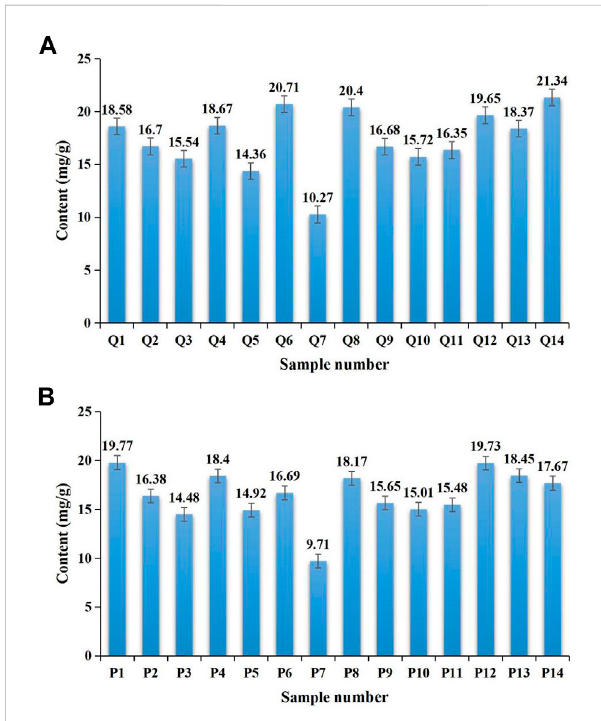
FIGURE 4 Total content of phenolic acids in the 14 batches of RPS (A) and SPS (B) samples.